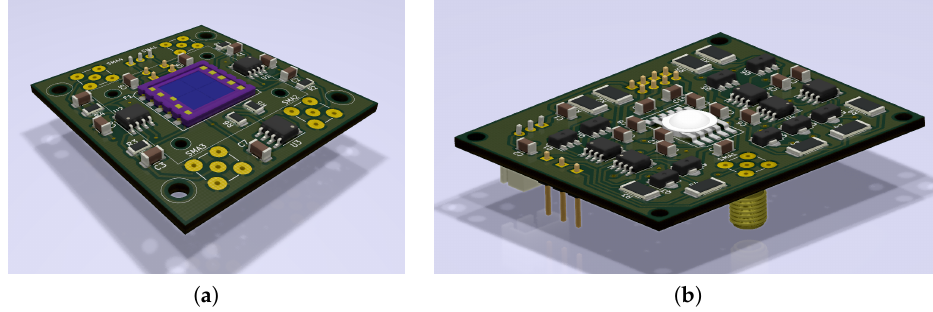
Figure 3. Electronic board designs: ( a ) Receiver board. ( b ) Emitter